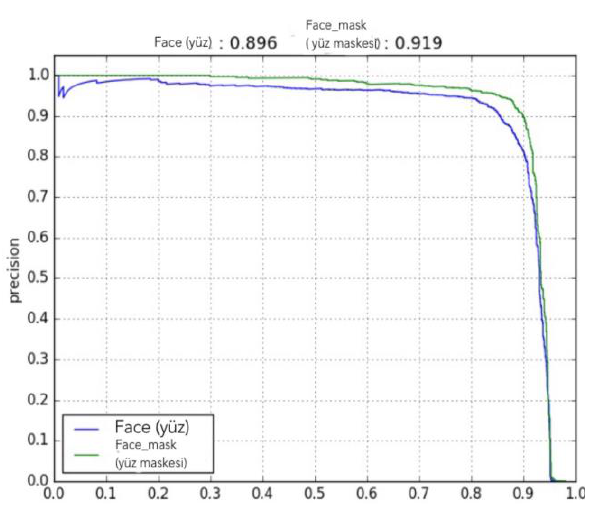
Figure 3.1 Precision-Recall Results